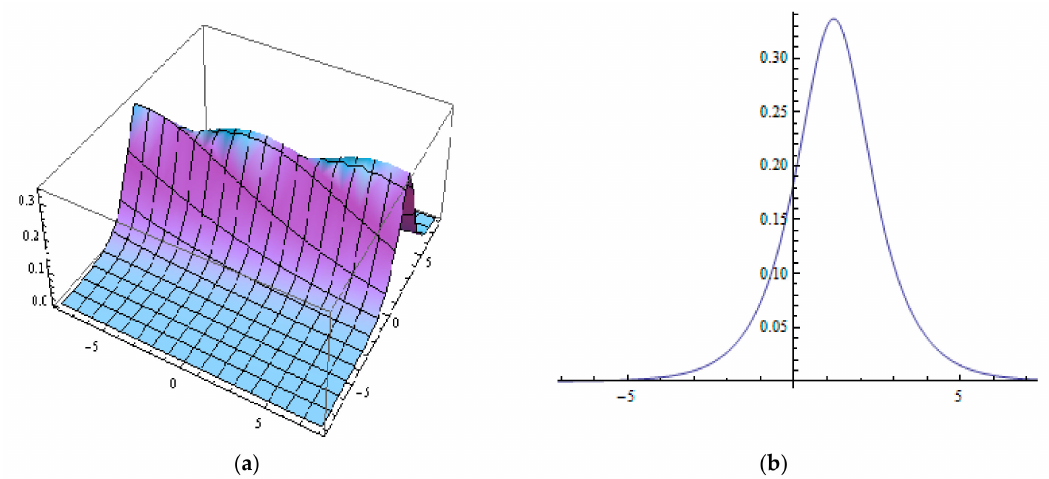
Figure 3. ( a ) The Absolute value of exact solution Q 17 when s 0 = 2, ε = 0.2, α = − 2, σ = 0.1, η = 2, ζ = 1, q = 11 and ( b ) is the projection Q 17 in 2D.